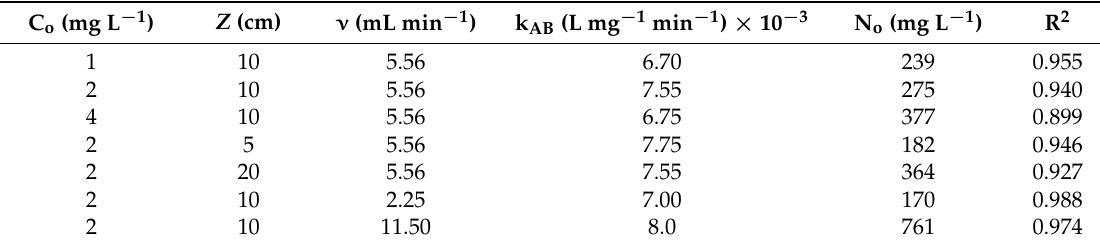
Table 5. Adam–Bohart parameters at different conditions for the adsorption of EE2 on PMPS particles using a linear regression analysis.